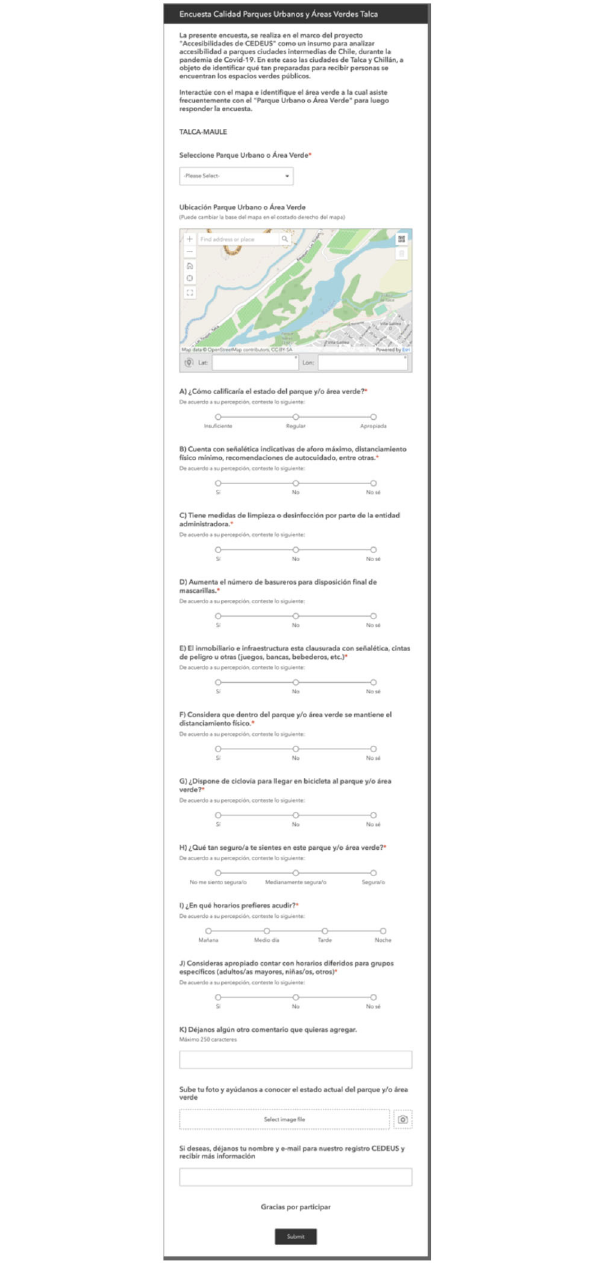
FIGURE A1 | This shows the survey form in Spanish.